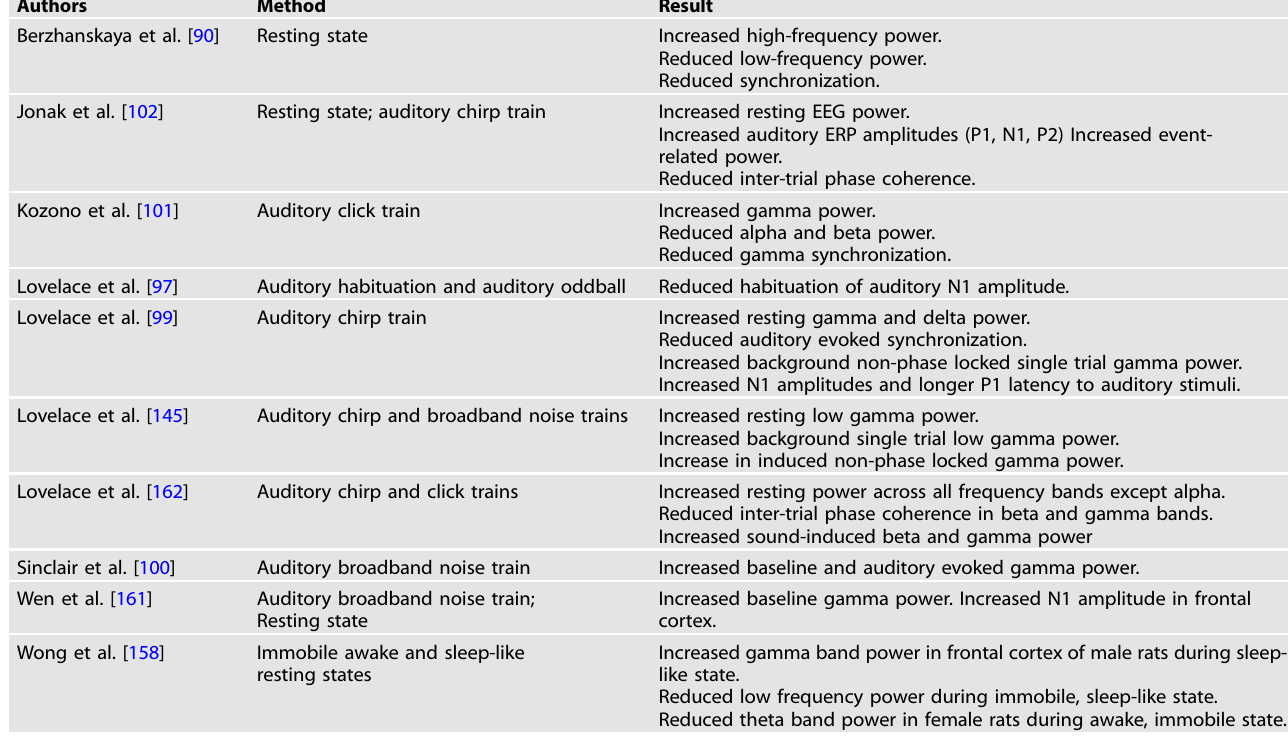
Table 3. EEG fi ndings in the Fmr1 KO rodent model of